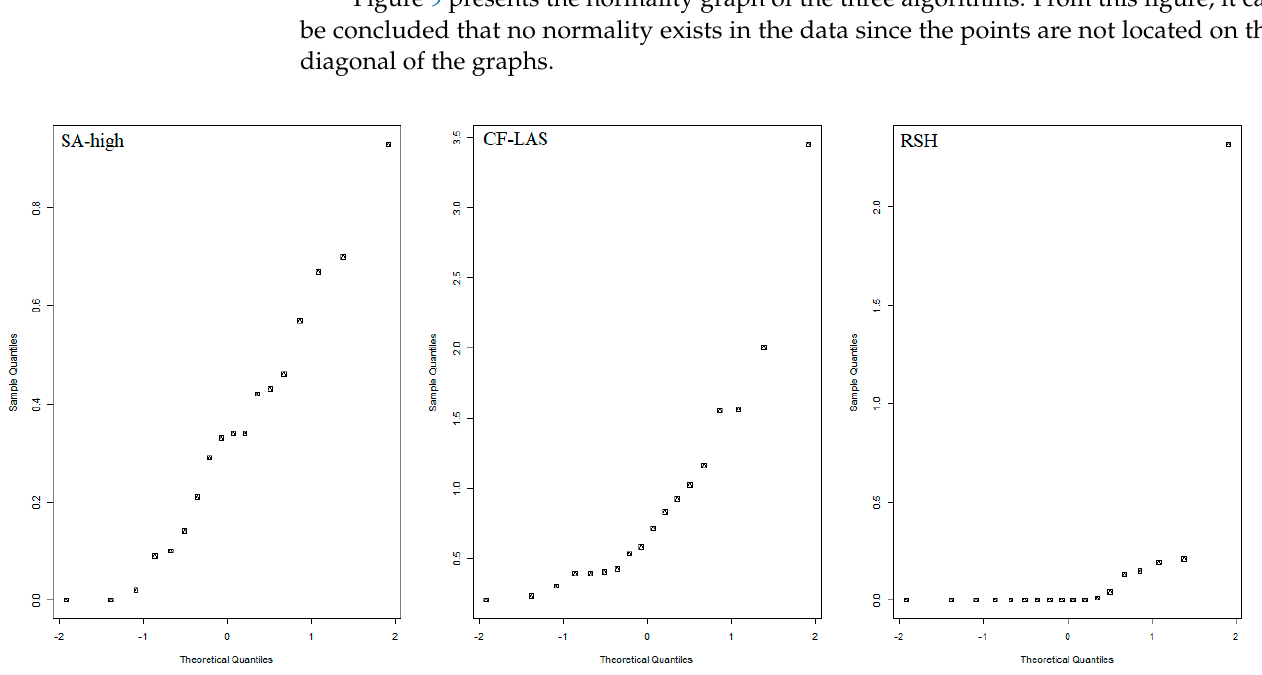
Figure 10. Box-and-whisker plot to evaluate homoscedasticity between the compared algorithms. The Welch and Box test [58] was performed in order to perform statistical analysis with robust ANOVA using the WRS R package [59] to compare the three algorithms using the 10% of the trimmed means. The obtained p -value was 1.912572 × 10 − 5 , and the null hypothesis was refuted. The value F w of the statistician was 18.31316, and the degrees of freedom were v 1 = 2 and v 2 = 22.47213. 4. Discussion This methodology is used to generate the first plan of attention to PSR factors. In the case study, the budget consumption matrix is obtained from the hp1 instance. Still, in a real case, its preparation requires great effort, since multiple meetings between the com- pany departments are needed to agree on the amounts used to attend each risk factor and establish the budget ceiling. When solving the optimization model of this instance, Table